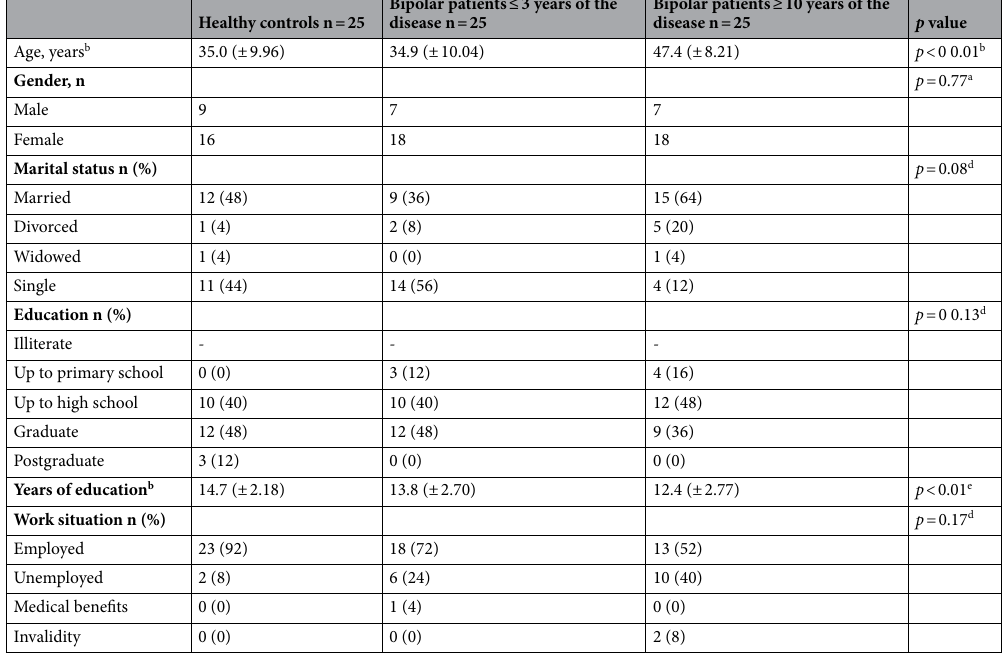
Table 1. Sociodemographic characteristics of the sample. a χ 2, b Mean (± SD), c One-way ANOVA followed by Dunn´s post hoc, d Fisher’s exact test e Kruskal Wallis.